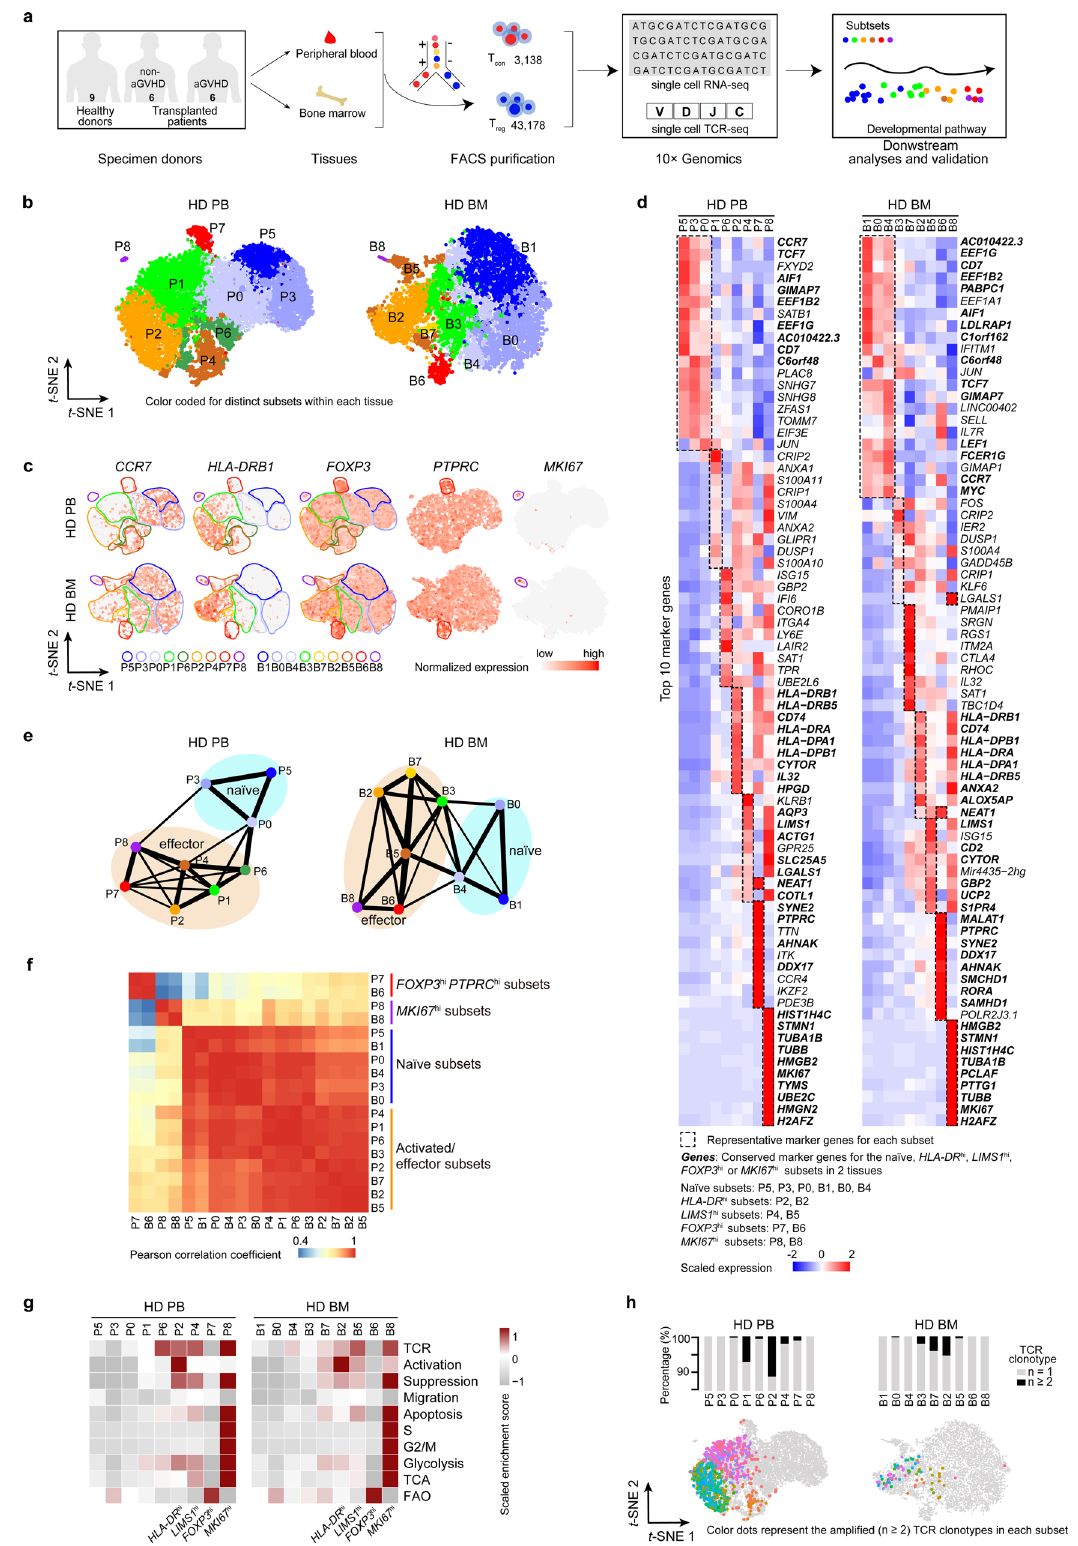
were selectively expressed by different subsets (Supplementary Fig. 3f). Particularly, the HLA-DR hi subset strongly expressed TGFB1 , CCR3 and CCR10 . The LIMS1 hi subset highly expressed IL10 and CCR9 . The FOXP3 hi subset highly expressed IL2RA , CTLA4 , CCR4 , CXCR4 and SELL . The MKI67 hi subset highly expressed LGALS1 and ITGAE